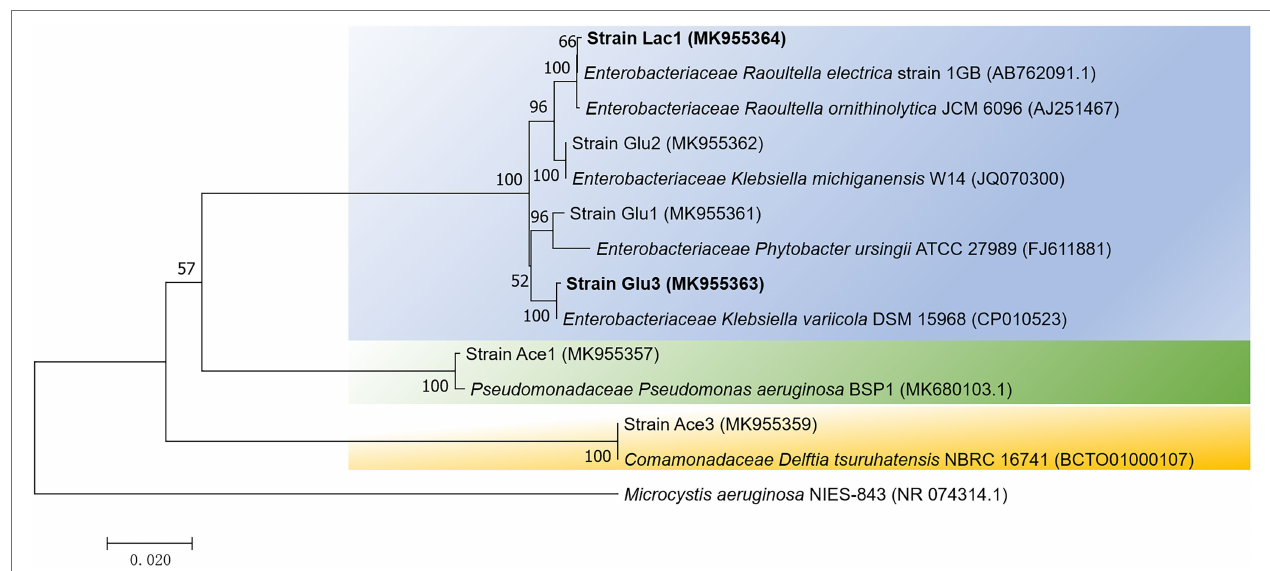
FIGURE 2 | A neighbor-joining phylogenetic tree showing the relationship of the 6 isolates from enriched cultures. The tree was constructed based on 16S rRNA gene fragments with alignment lengths longer than 1,300 bp. The scale bar represents 2% sequence dissimilarity, and bootstrap values >50% are indicated at each node. Microcystis aeruginosa, a member of Cyanobacteria, was recruited as the outgroup